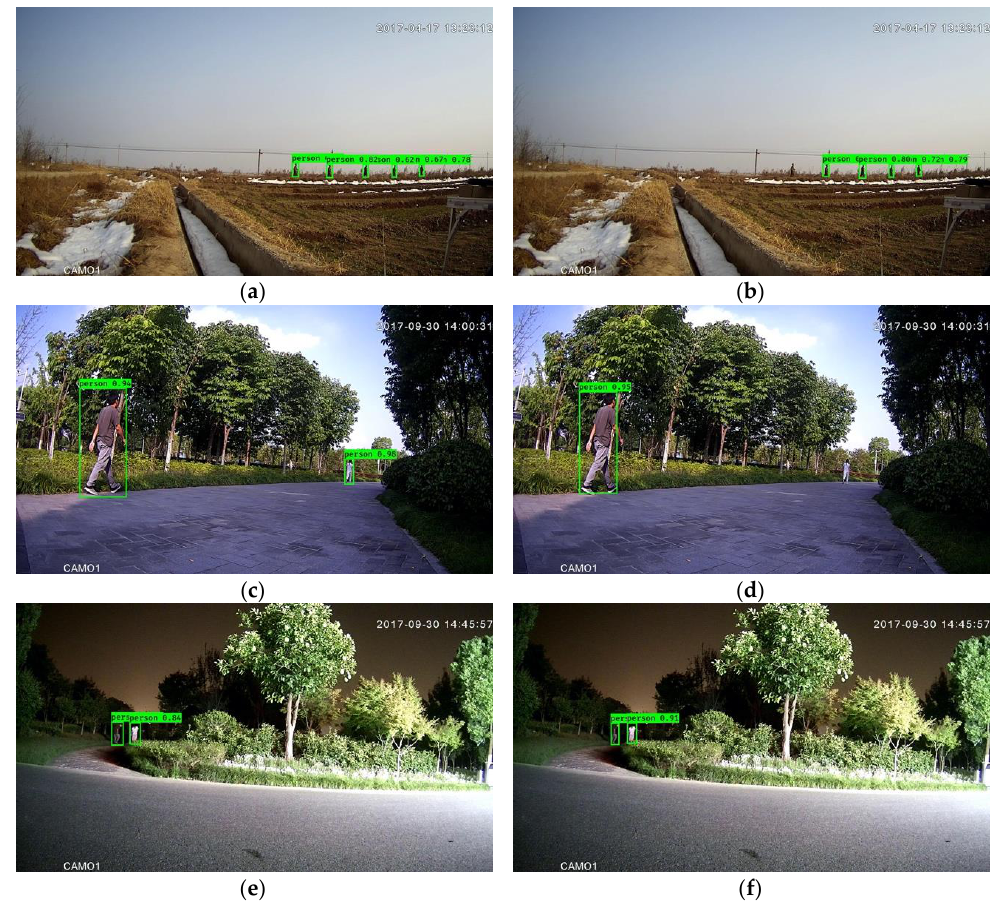
Figure 8. Outcomes of the framework with 320 × 320 input size without downsampling ( a,c,e ) and with downsampling ( b,d,f ). The left column and right column correspond to the same